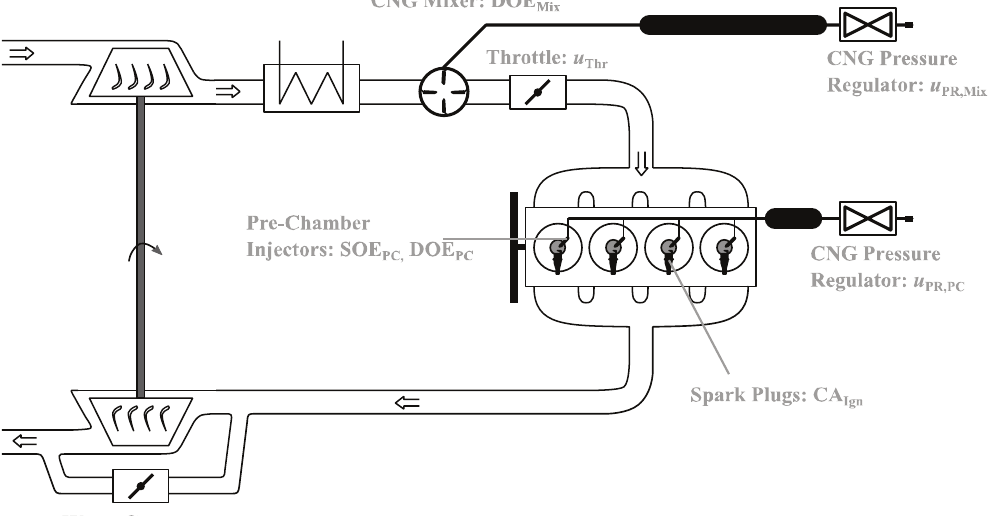
Fig. 1. Schematic of the research gas engine with scavenged pre-chambers (engine 2). Engine actuators and their corresponding control variables (referred to as actuator signals) are labeled